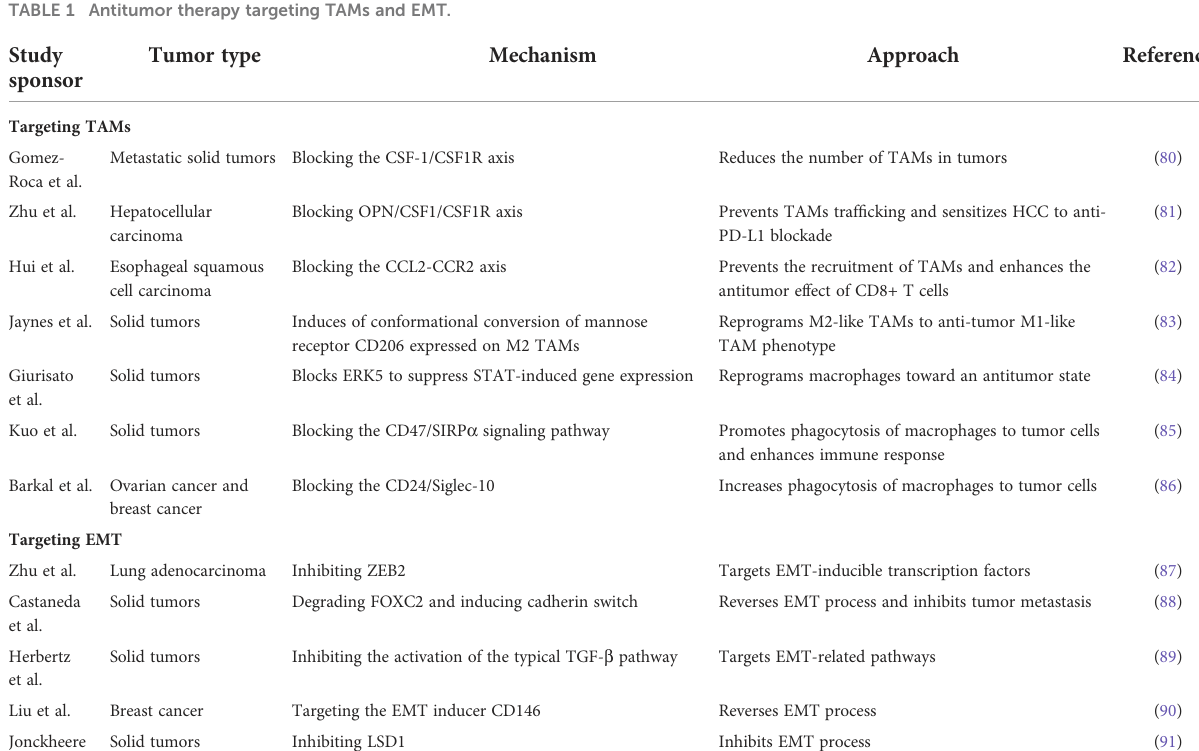
TABLE 1 Antitumor therapy targeting TAMs and